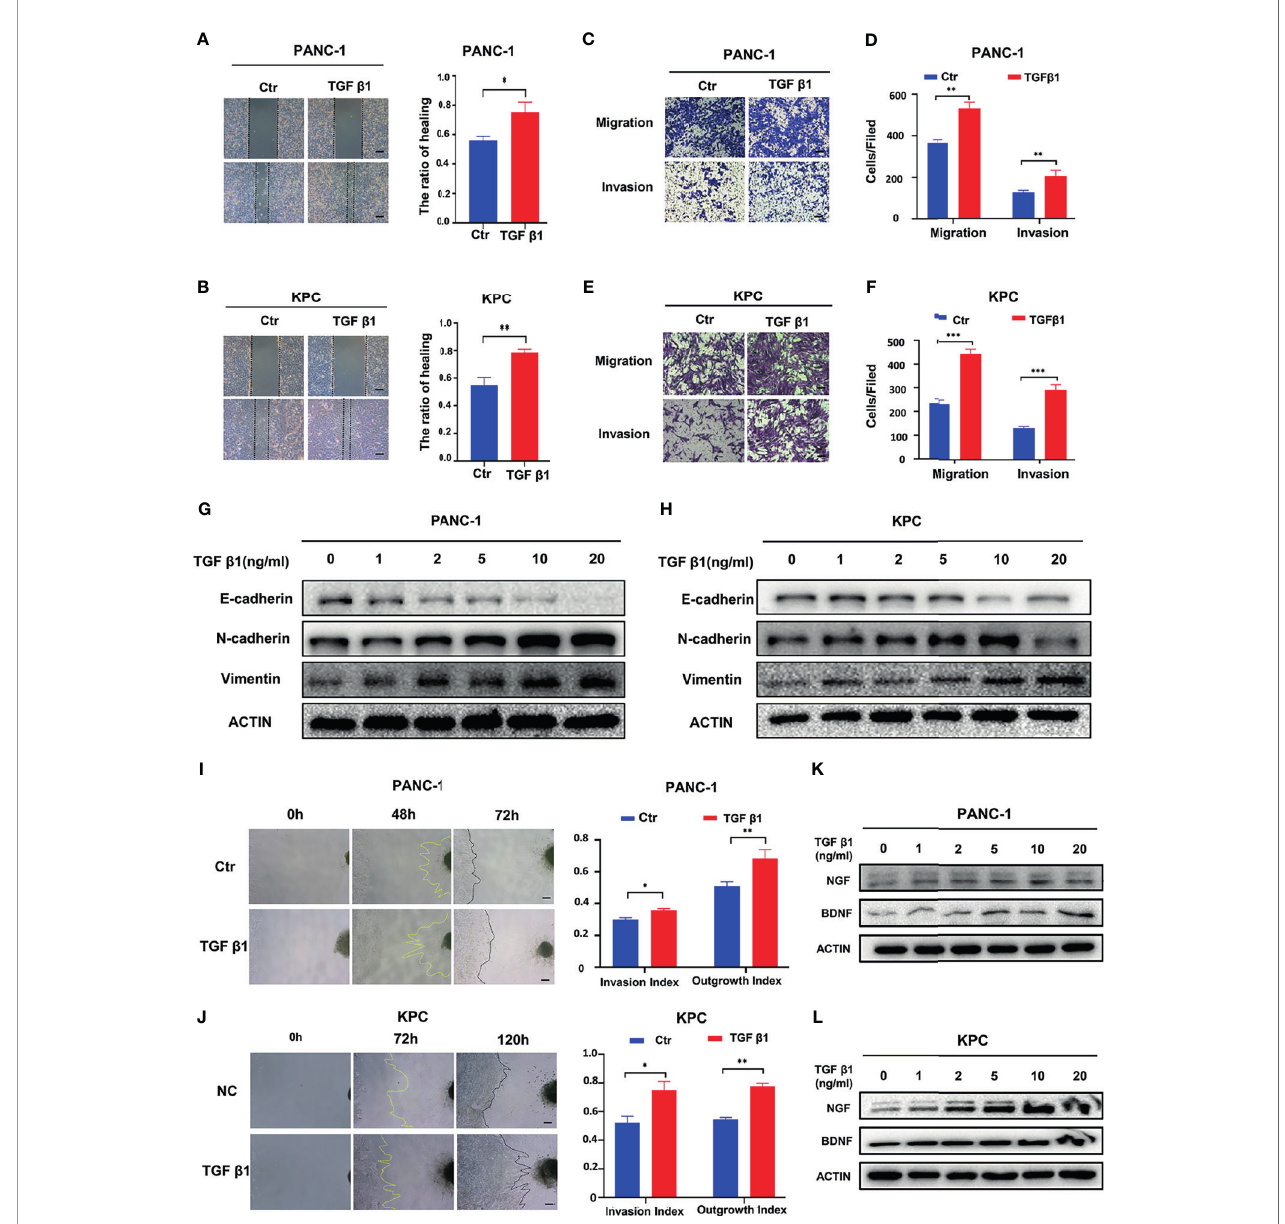
FIGURE 3 | Activating SMAD2/3 signaling can promote perineural invasion. (A, B) Wound healing assays of the control group and TGF b 1 group, scale bar = 200 m m; (C-F) Migration assay and invasion assay of the control group and TGF b 1 group, scale bar = 100 m m; (G, H) Western blotting analysis of the expression of N-cadherin, E-cadherin, Vimentin; (I, J) Cancer cell-DRG coculture model of the control group and TGF b 1 group, scale bar = 200 m m; (K, L) Western blotting analysis of the expression of NGF and BDNF. * p < 0.05, ** p < 0.01, *** p <